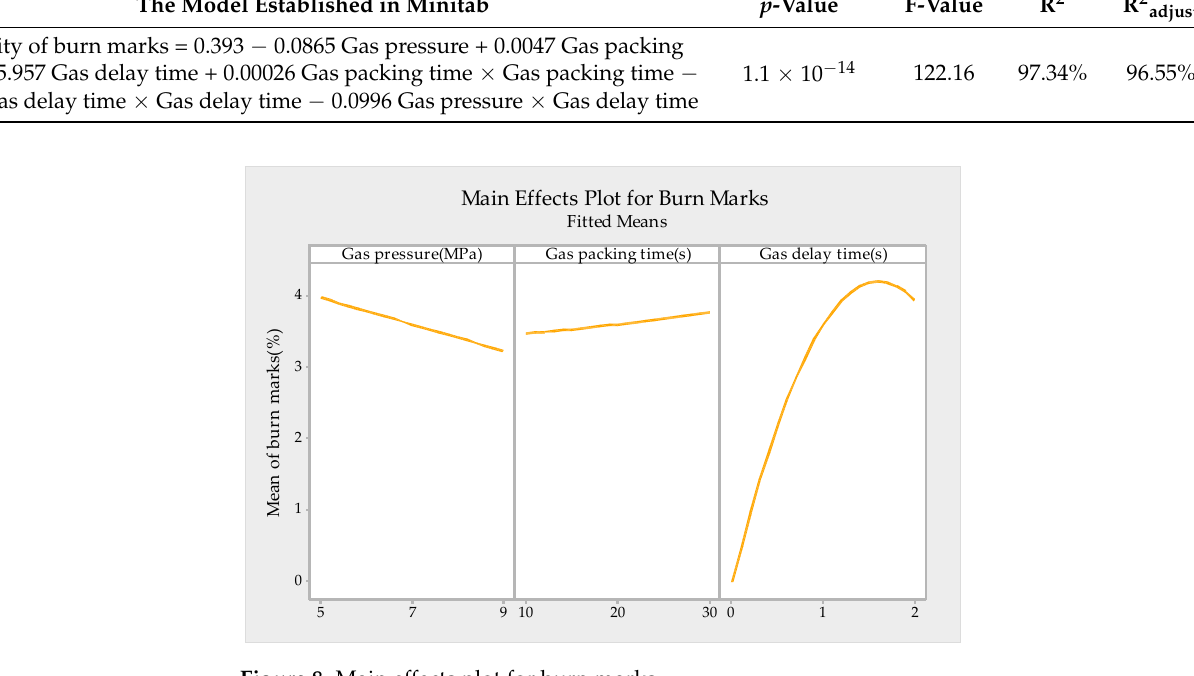
Figure 8. Main effects plot for burn marks. According to the F-distribution table, F 0.05 (6,20) = 2.6. Additionally, Table 4 shows that F = 122.16 > F 0.05 (6,20), indicating the model is significant at a significance level of 0.05. Additionally, the values of R 2 and R 2 adjust are 97.34% and 96.55%, respectively, which are